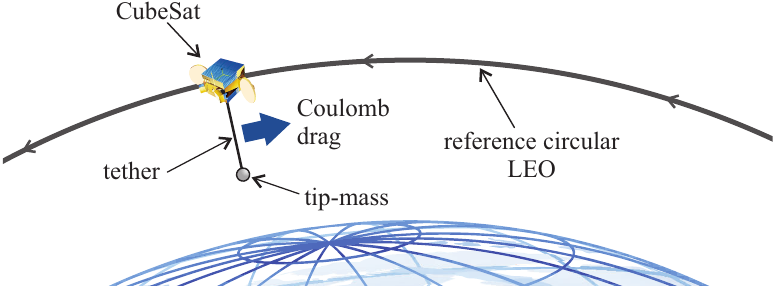
Figure 2. Plasma brake